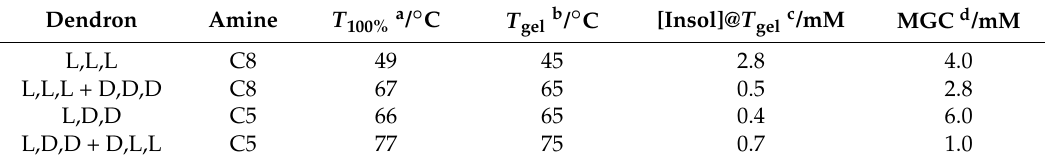
Table 2. Comparison of data from VT NMR experiments with dendrons/amines and